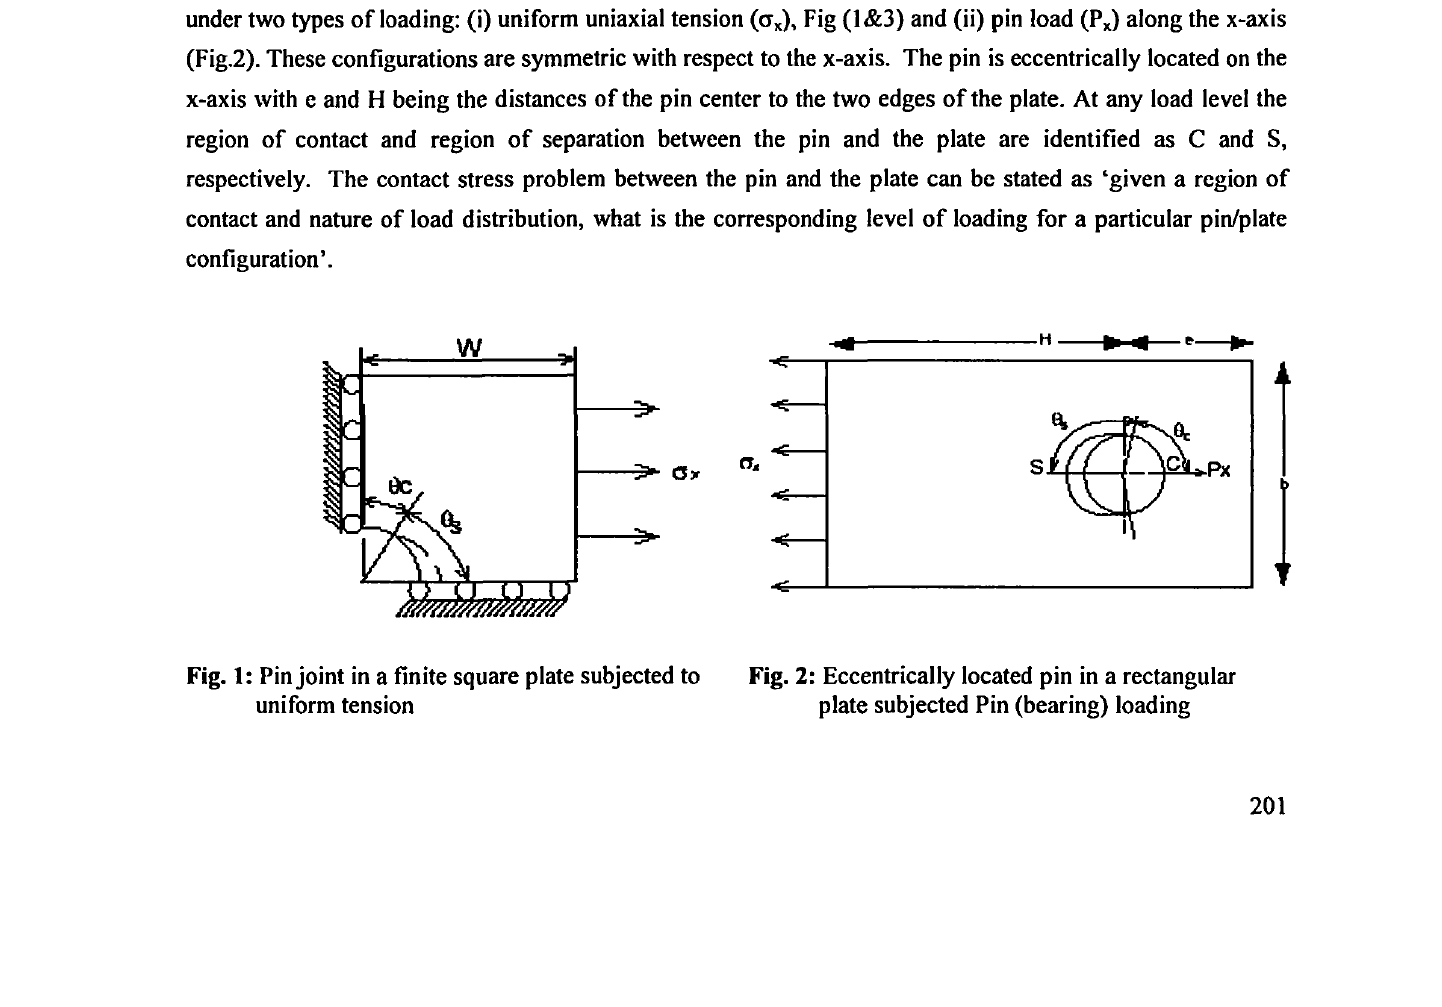
Fig. 1: Pin joint in a finite square plate subjected to uniform tension